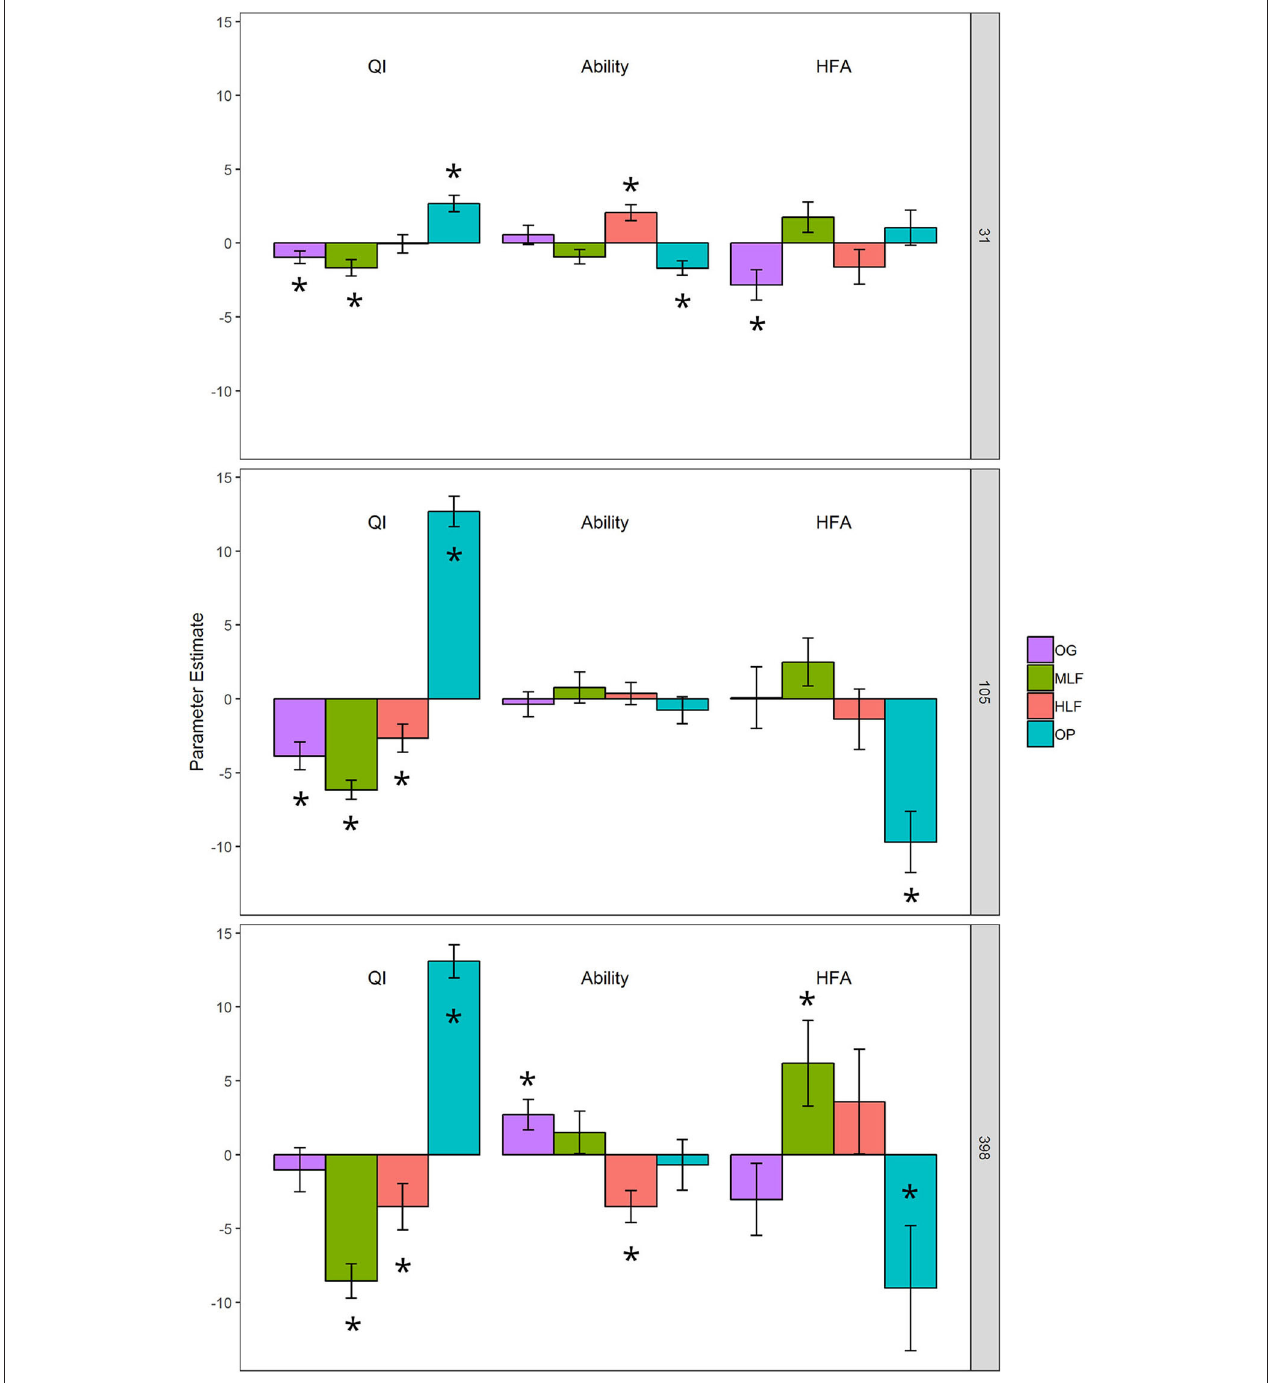
FIGURE 4 | DART output calculated from % litter mass loss from litter decomposition microcosms after 31, 105, and 398 days: QI (litter quality index ranking the chemical quality of litters within the study), Ability (the functional capabilities of the microbial decomposer community to decompose all litters), and HFA (home-field advantage or the relative advantage of a decomposer community decomposing its “home” litter type). The bars are parameter estimate means ± 1 SE. “*” above or within bars represent a statistically significant difference from the intercept ( y = 0) at p < 0.05. The intercept represents the average litter mass loss for all observations in the dataset after controlling for litter, soil and home-field pairings.